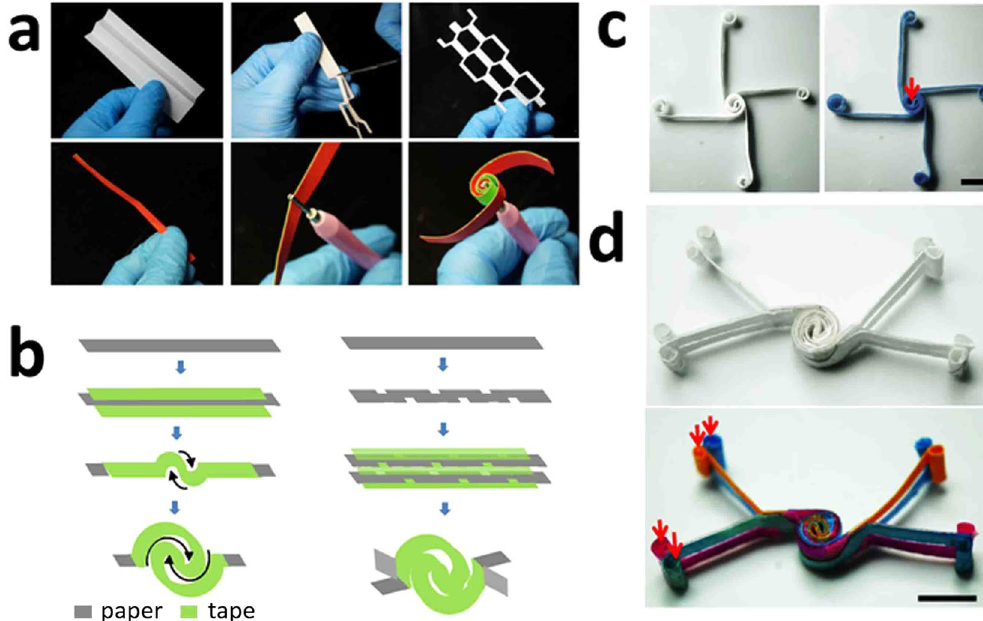
Figure 1. ( a ) Photographs showing the quilling and kirigami processes. ( b ) Schematic illustration showing the procedure for fabricating the 2D and 3D vPADs using the principles of quilling and kirigami. ( c ) Photographs of the 2D vPAD before and after the introduction of 0.10 M PBS solution containing 0.010 M coomassie brilliant blue. The inlet for introduction of the solution is indicated by the red arrow. Scale bar: 10 mm. ( d ) Photographs of the 3D vPAD before and after the introduction of 0.10 M PBS solutions containing 0.010 M coomassie brilliant blue, 0.010 M rhodamine B, 0.010 M methyl orange and 0.010 M bromocresol green, respectively. The inlets for introduction of the solutions are indicated by the red arrows. Scale bar: 10